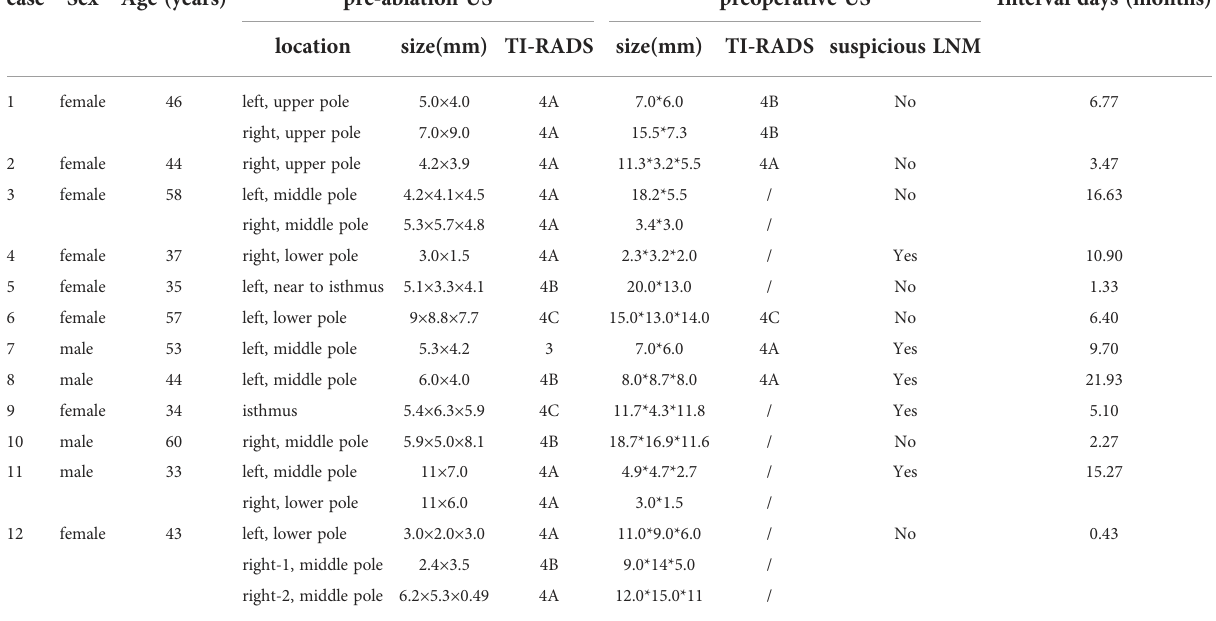
TABLE 1 Baseline clinical characteristics of enrolled